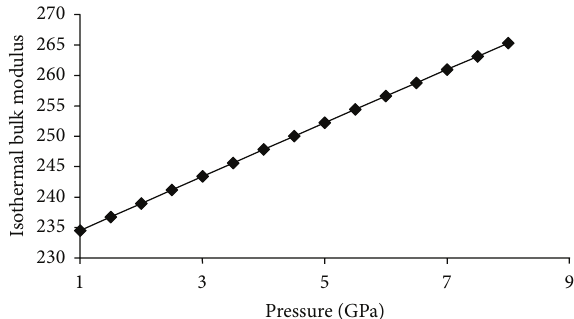
Figure 4: Variation of isothermal bulk modulus ( 𝐵 𝑇 ) with pressure for individual